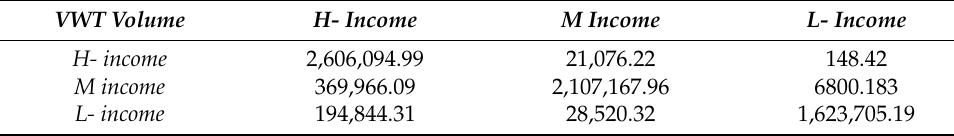
Table A3. Volume of VWT in different income countries (Mm 3